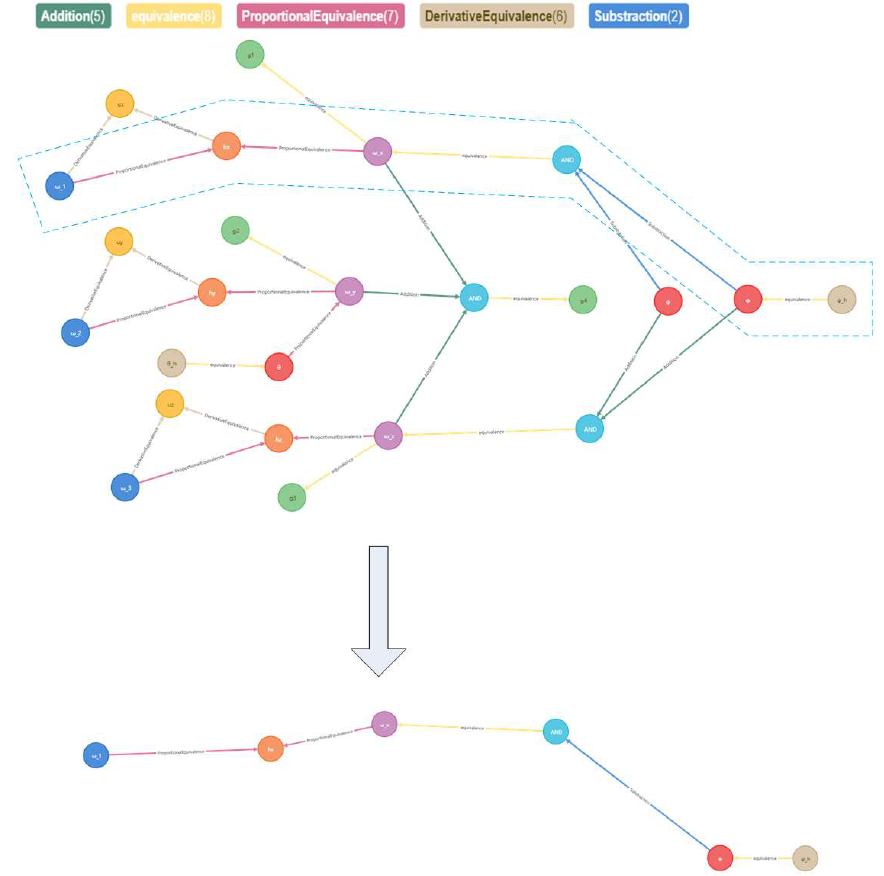
Figure 7. Visualization path finding process of Neo4j.